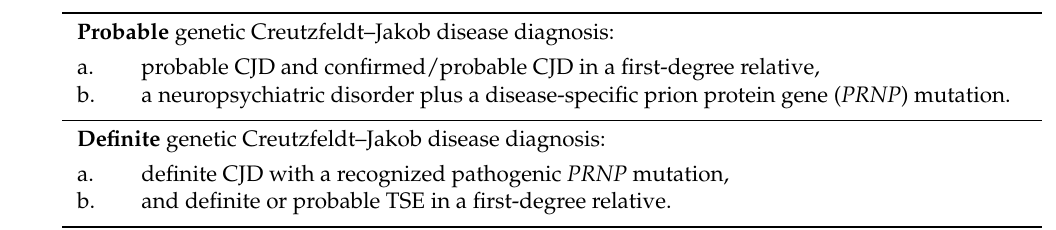
Table 4. Diagnostic criteria for probable and definite